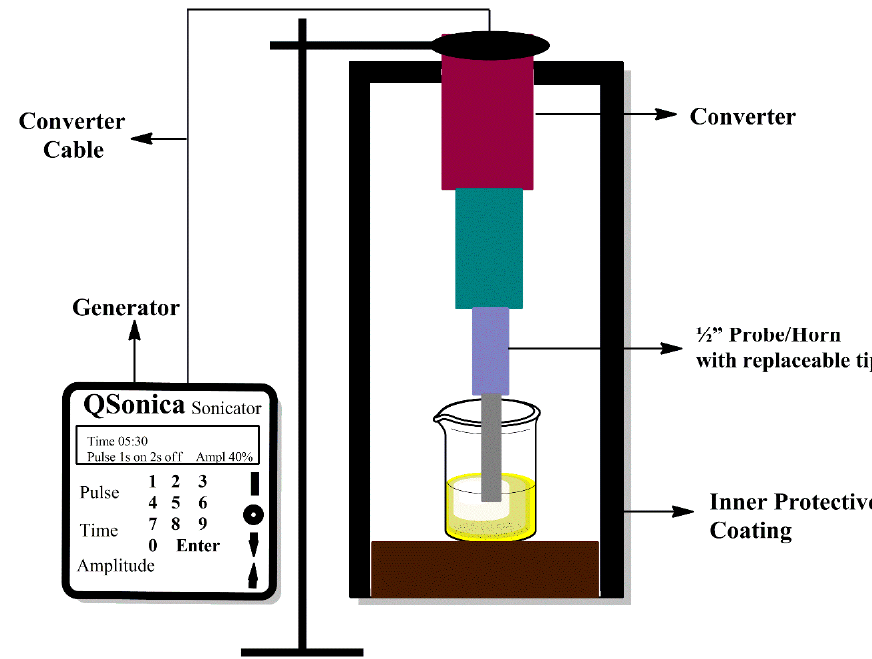
Figure 1. Ultrasound equipment for biodiesel production and sonication of P50S50 blended oil with nanoparticles.